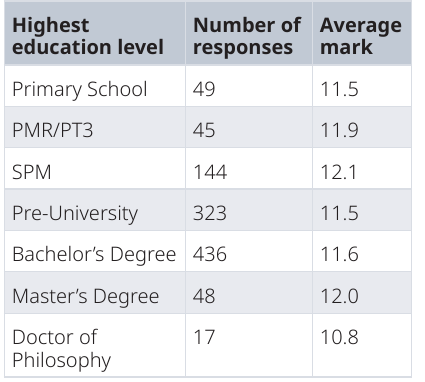
Table 4. Responses according to education level.